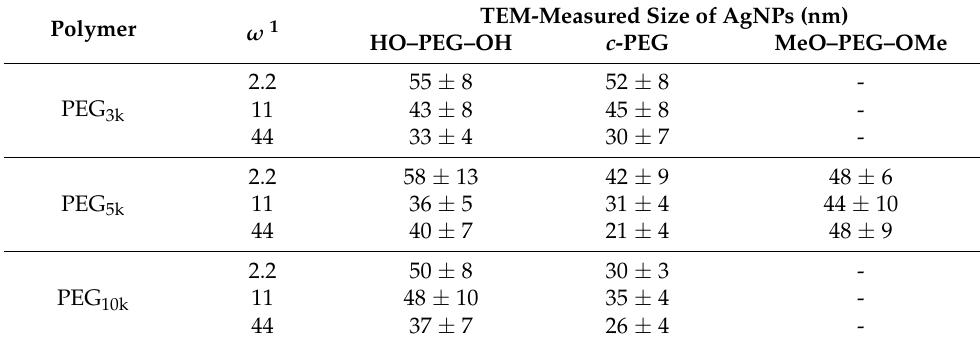
Table 1. Summary of the TEM-Measured Size of AgNPs Prepared in the Presence of HO–PEG–OH, c -PEG, and MeO–PEG–OMe with Various Molecular Weight and ω